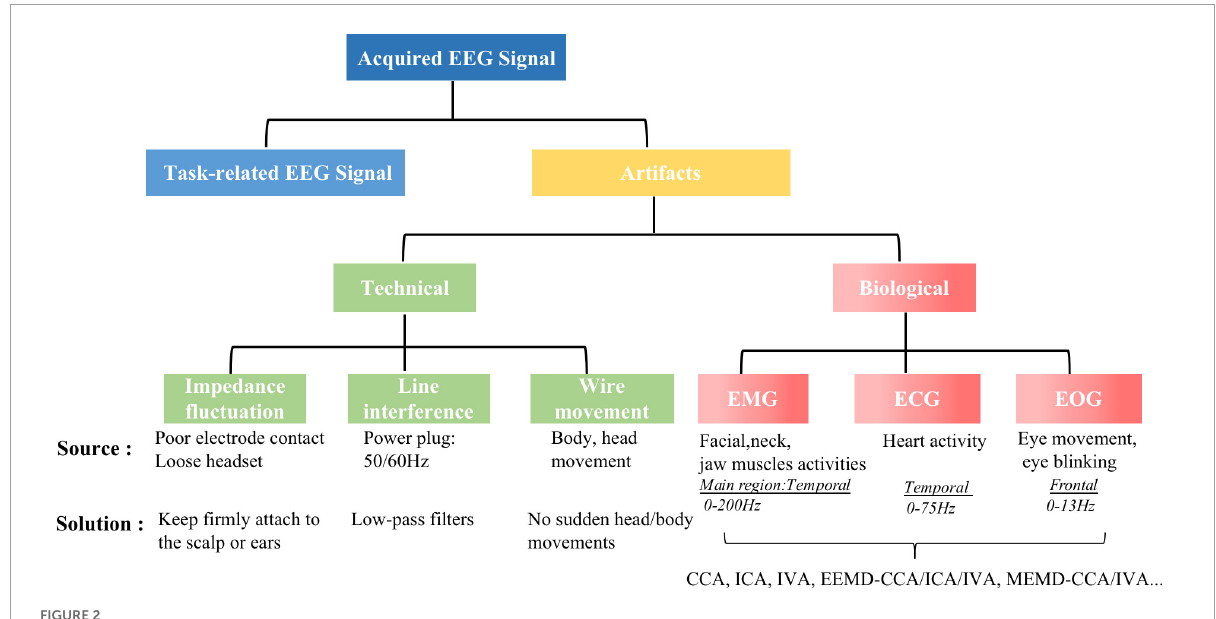
FIGURE2 The sources of artifacts in EEG signal and the removal methods.